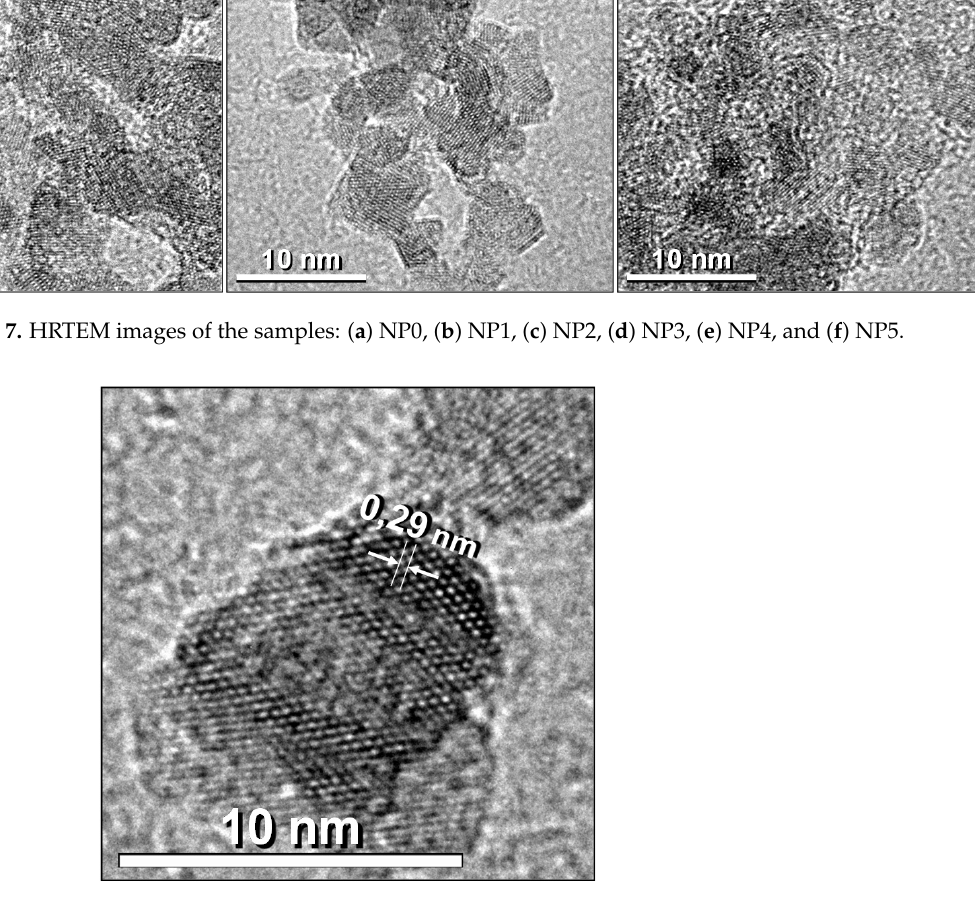
Figure 8. HRTEM image of the sample NP4: detail of atomic columns of 0.29 nm spacing corre- sponding to (220) magnetite planes.